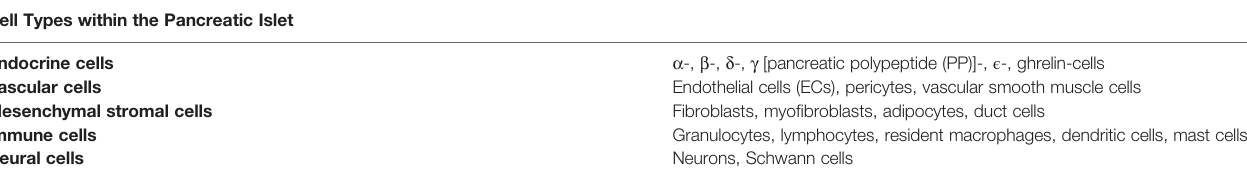
TABLE 1 | Current understanding of different cells residing within the pancreatic islets. [Adapted from (17, 18)]. Cell Types within the Pancreatic Islet